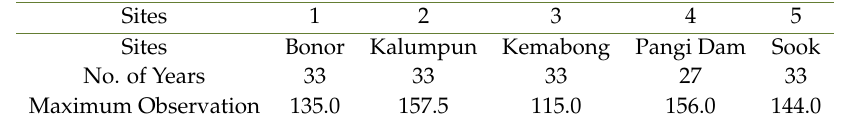
Table 1. Information of each site.